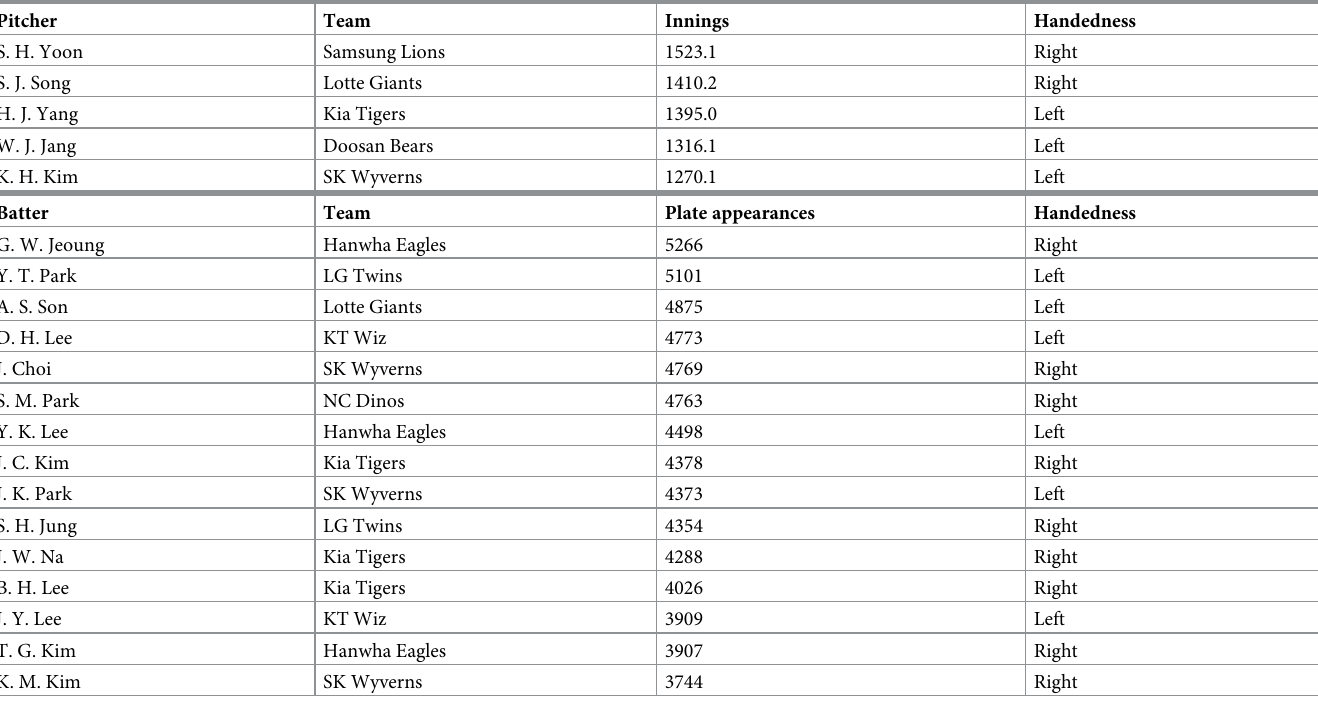
Table 1. List of players considered in this